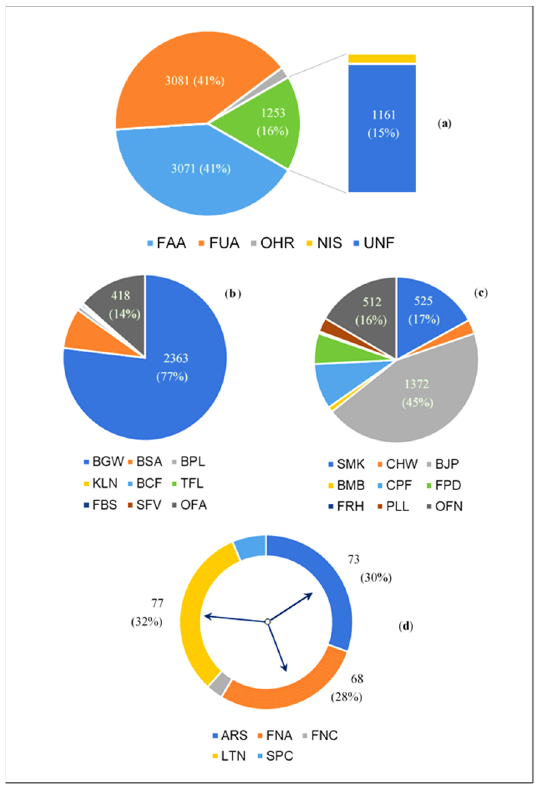
Figure 1. Averaged fire number distribution in terms of fire causes throughout the years studied: ( a ) among FAA, FUA, OHR, NIS and UNF, ( b ) within the fire causes of FAA, ( c ) within FUA and ( d ) from both OHR and NIS.